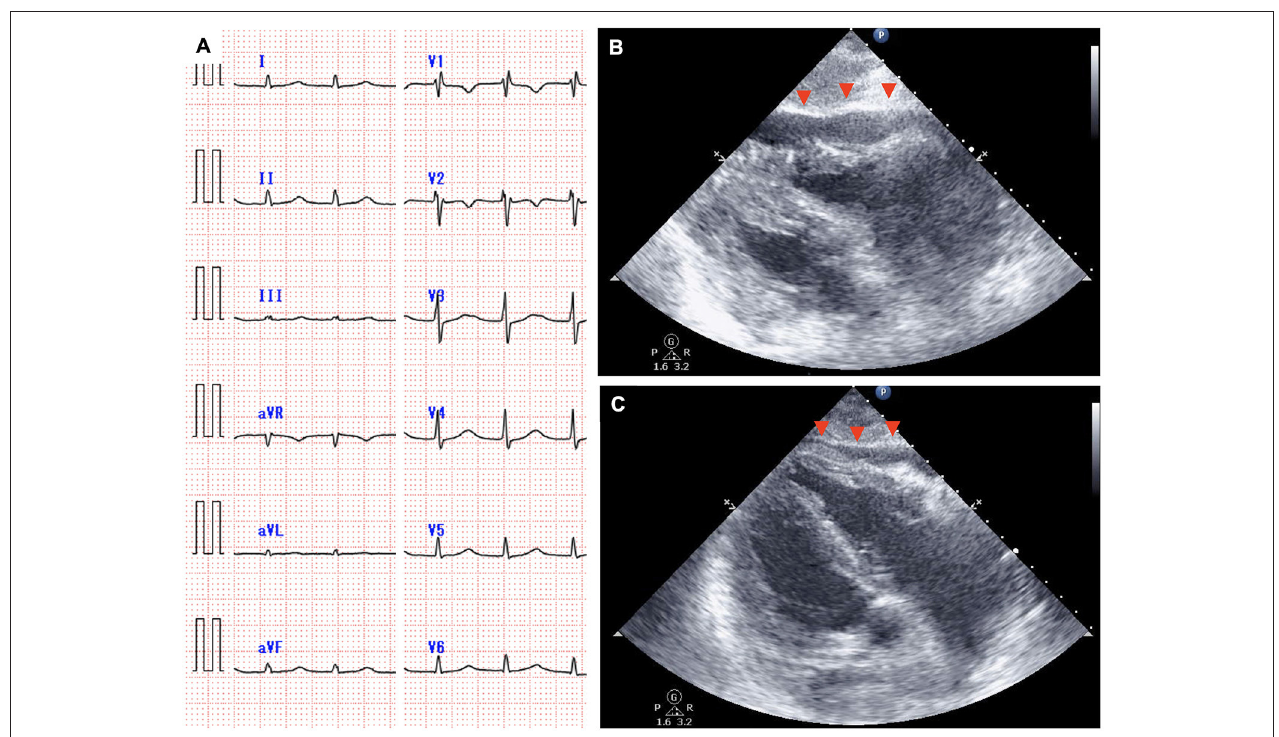
FIGURE 4 | An electrocardiogram obtained on day 7 showing narrow QRS tachycardia with the absence of the P wave (A) , and echocardiography showing rapidly accumulated pericardial effusion with the collapse of the right heart chamber [ (B) , arrowhead]. Pericardial effusion decreased and the collapse of the right heart chamber resolved on day 8 [ (C) ,